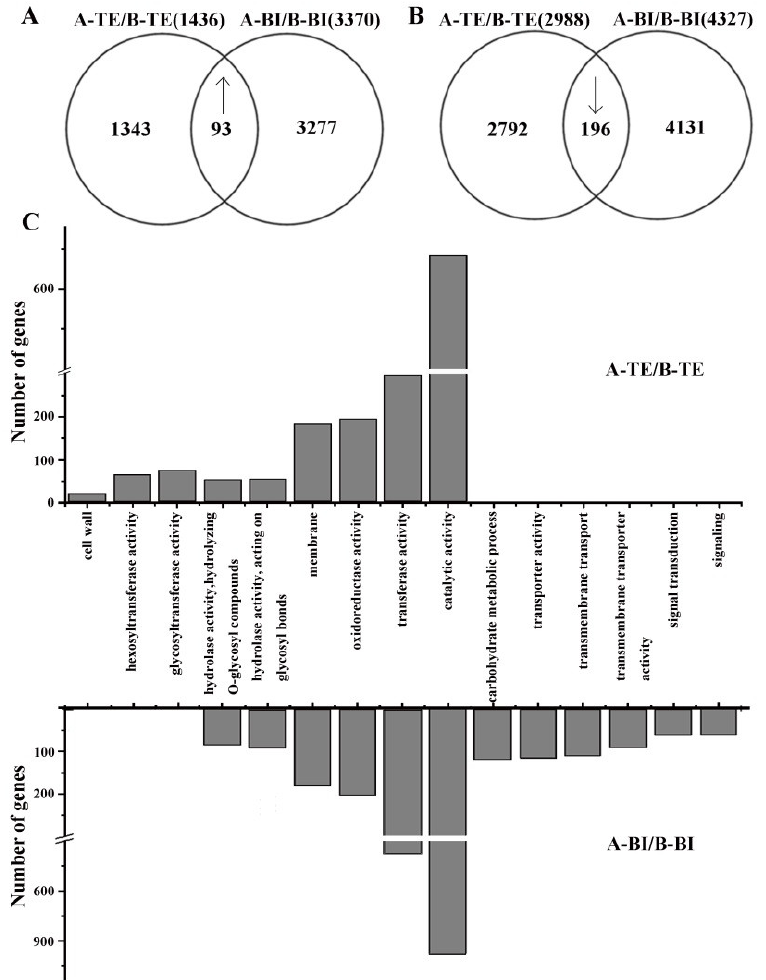
Figure 3. Functional distribution of identified genes in 09-05A and 09-05B flower buds at the TE and BI stages of B. juncea . RNAs were extracted, sequenced, and analyzed. Genes in flower buds in 09-05A were compared with those in 09-05B at the two stages, respectively. “ ↑ ” represents upregulation; “ ↓ ” represents downregulation. ( A ) Comparison of upregulated DEGs identified in 09-05A/09-05B. ( B ) Comparison of downregulated DEGs identified in 09-05A/09-05B. ( C ) Predicated and categorized functions of DEGs.